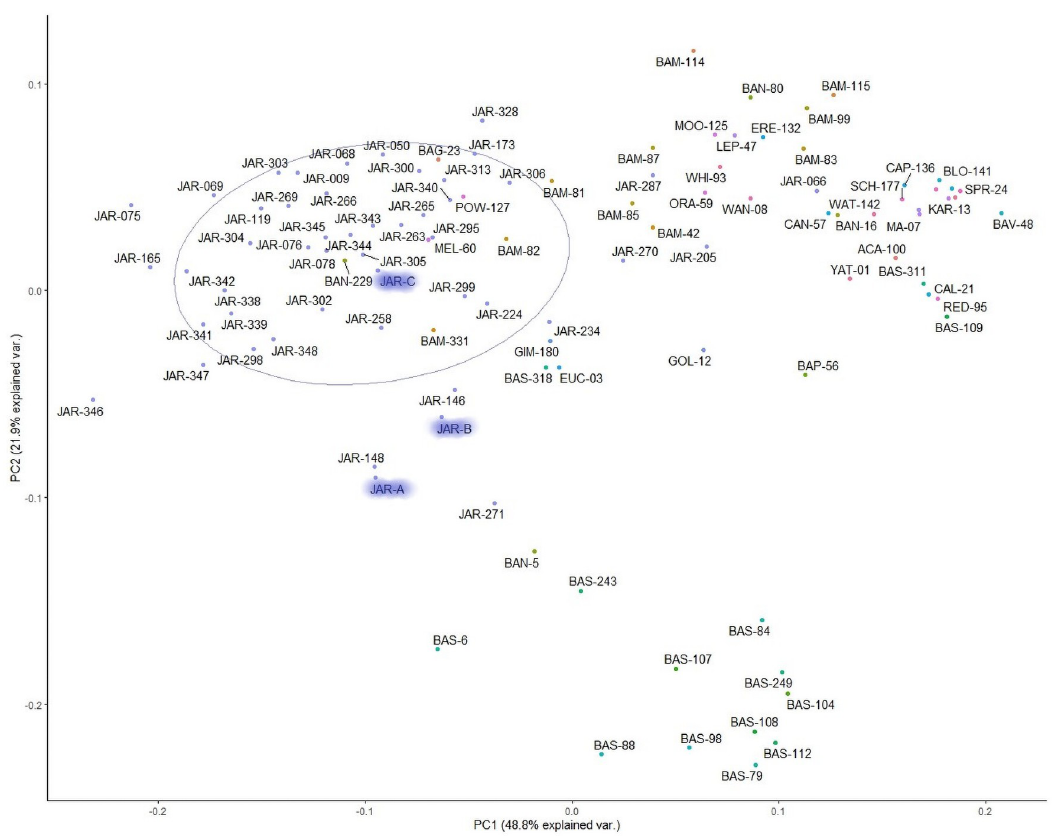
Fig 5. Cluster analysis with new Jarrah samples (JAR-A, JAR-B, JAR-C).